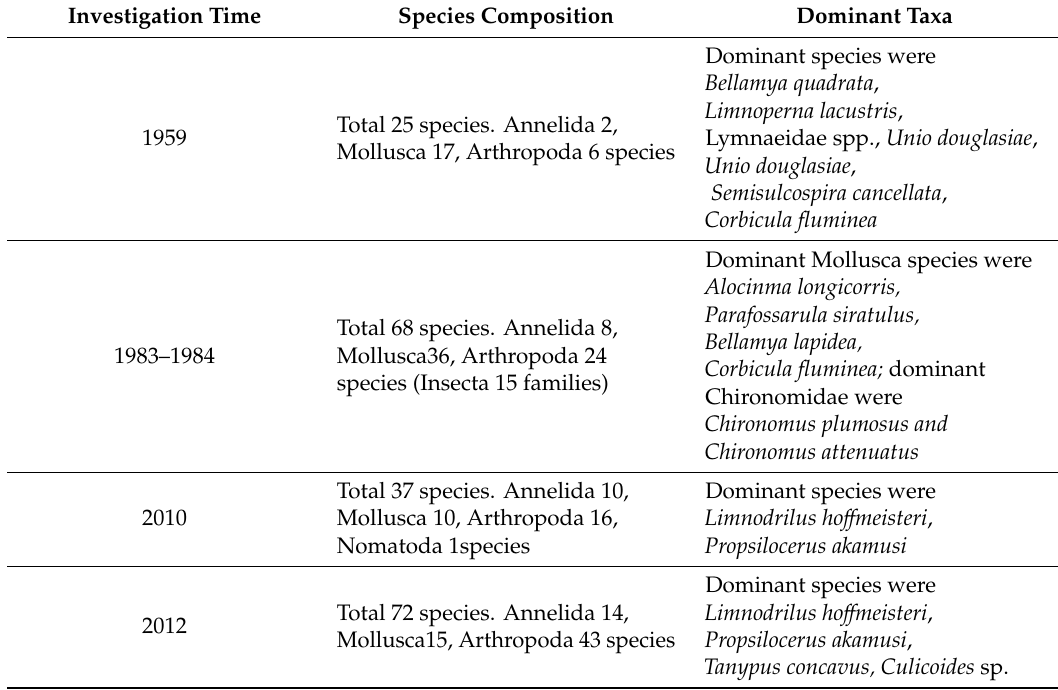
Table 6. Characteristics of macroinvertebrate communities in the Nansi Lake during di ff erent